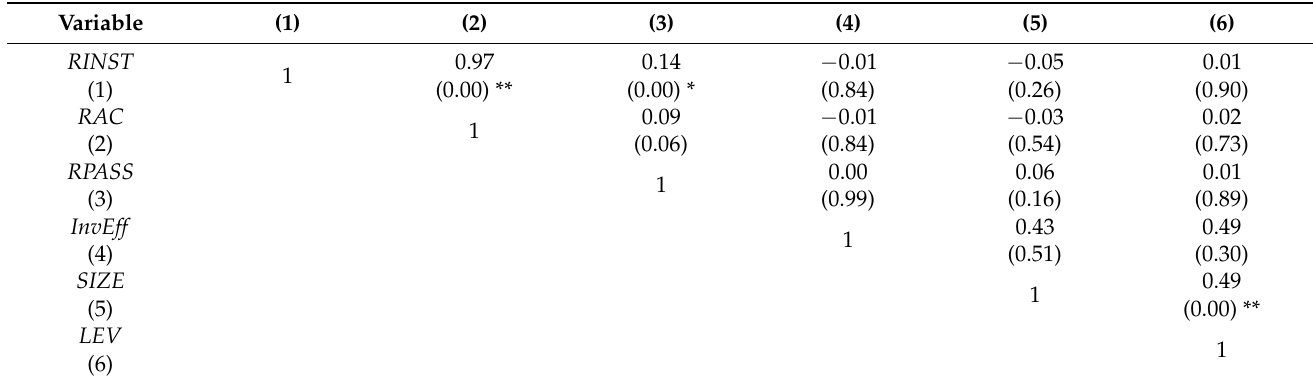
Table 3. Correlation matrix.